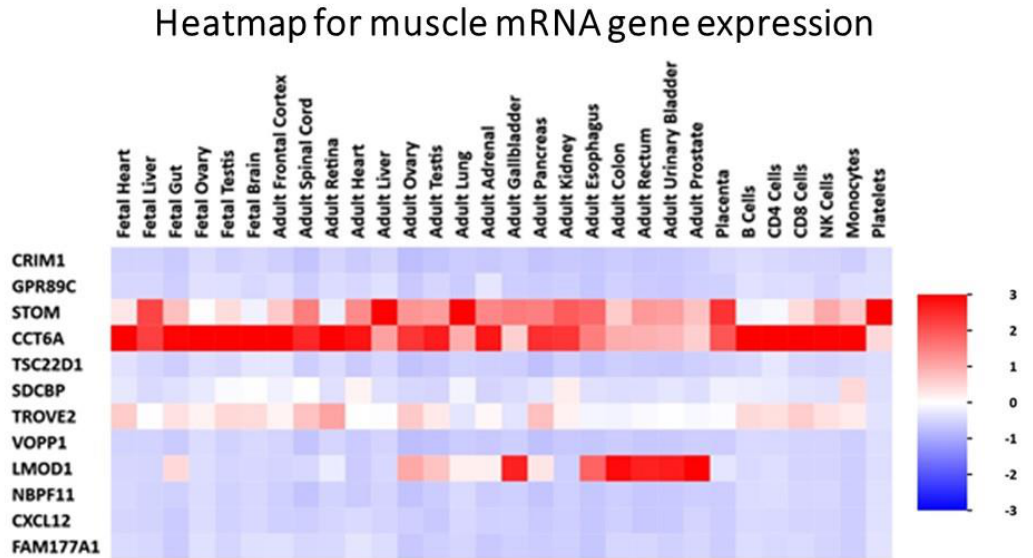
Figure 7. Heat map with differences in gene expression from SKM signatures from the 20 genes identified as shown in Figure 6. Gene CCT6A shows “hot red” values perhaps indicating higher activity in several fetal and adult pathways and, interestingly, from the immune systems through B cells, CDK4, CDK8, monocytes and NK cells.